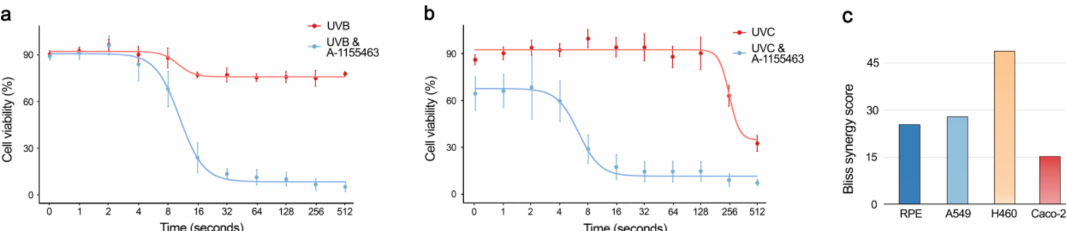
Figure 8. Identification of physical factors, which trigger Bcl-xL-mediated apoptosis. ( a , b ) RPE cells were exposed to UVB or UVC radiation for the indicated times and covered with medium containing 1 µ M A-1155463 or 0.1% DMSO. After 24 h, viability of cells was measured using the CTG assay. Mean ± SD, n = 3. ( c ) Synergy scores of A-1155463-UVC combinations in 4 cell lines. Cells were treated with increasing A-1155463 concentrations and exposed UVC radiation for 0, 20, 40, 80, 160, and 240 sec. After 24 h cell viability was measured using the CTG assay. Synergy scores were quantified using Bliss model.